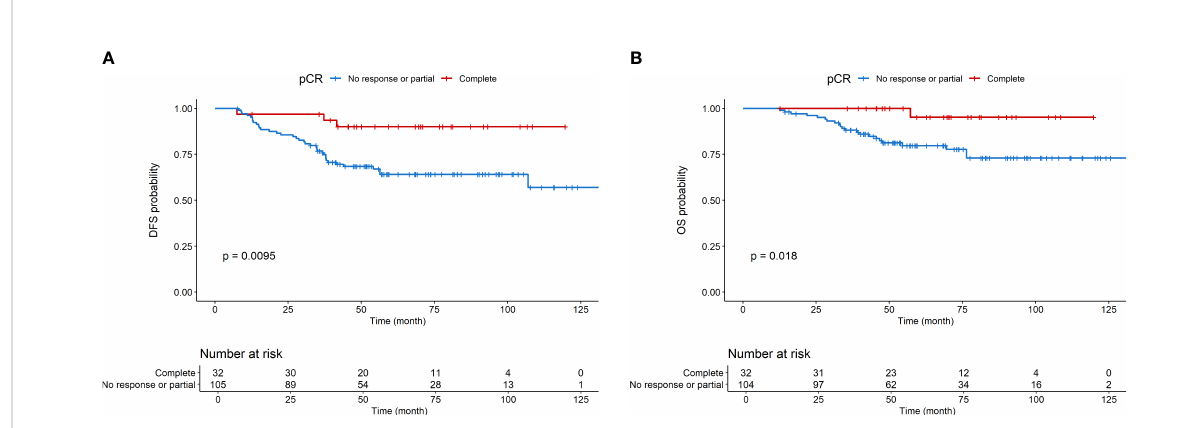
FIGURE 1 Disease-free survival (A) and overall survival (B) according to pCR.